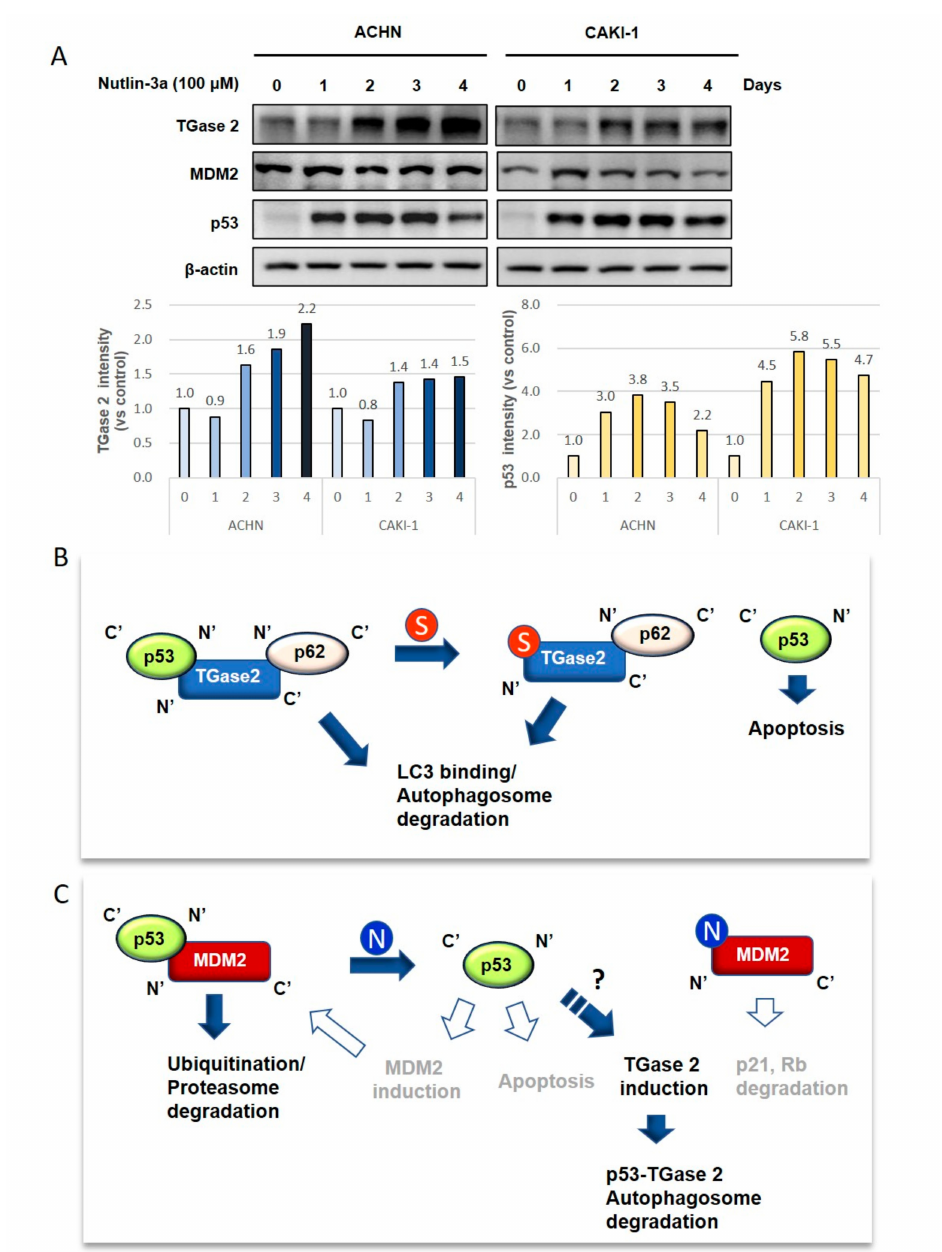
Figure 5. The proposed model explaining p53 regulation by TGase 2 and MDM2 in RCC: ( A ) TGase 2 expression was induced after MDM2 inhibition. ACHN and CAKI-1 cell were treated with nutlin-3a (10 µ M) in a time-dependent manner. ( B ) TGase 2 forms a triple complex with p53 and p62, which then moves to the autophagosome via binding of p62 to LC3. [15]. Next, p53 is degraded by the autophagic process. Streptonigrin inhibits TGase 2-p53 binding, which stabilizes p53 and triggers p53-mediated cell death. ( C ) P53-MDM2 binding causes proteasomal degradation of p53 via ubiquitination. Nutlin-3a inhibits the MDM2–p53 interaction, thereby inducing p53-mediated apoptosis. However, activated p53 may induce MDM2 transcription, which regulates p53 activity. This creates a feedback loop between p53 and MDM2 [28]. Therefore, MDM2 inhibition may have a temporal e ff ect on p53 activation. The released MDM2 also triggers degradation of tumor suppressors such as p21 and Rb, which can lead to uncontrolled cell growth. In this study, we observed only increased TGase 2 expression after nultlin-3a treatment, which is likely induced by p53 activity (bold). S, streptonigrin; N, nutlin-3a; closed arrows and bold font denote observations from this study; and open arrows and gray font denote information obtained from references but failed to observe changes (data not shown). LC3, microtubule-associated proteins 1A / 1B light chain